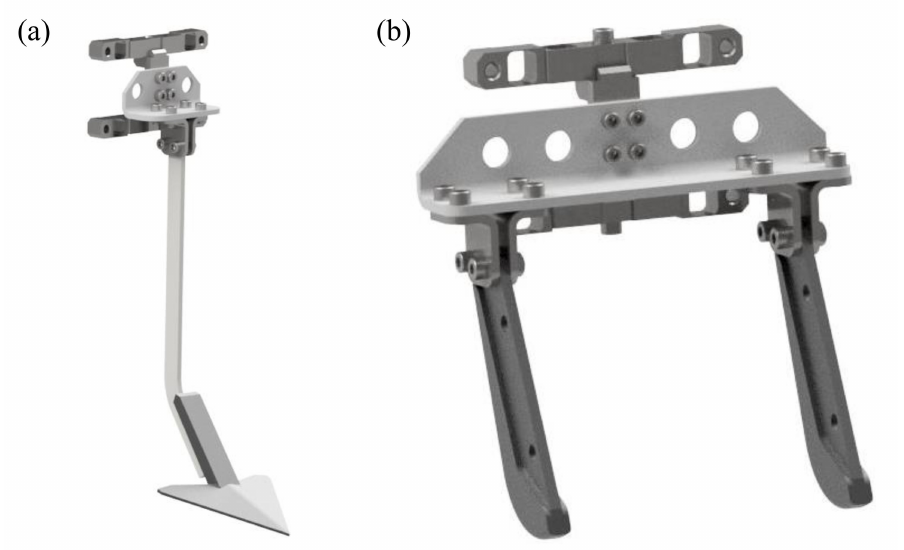
Figure 5. Transducer in configuration with various tool types; ( a ) coulter terminated with a goosefoot, ( b ) two coulters of a